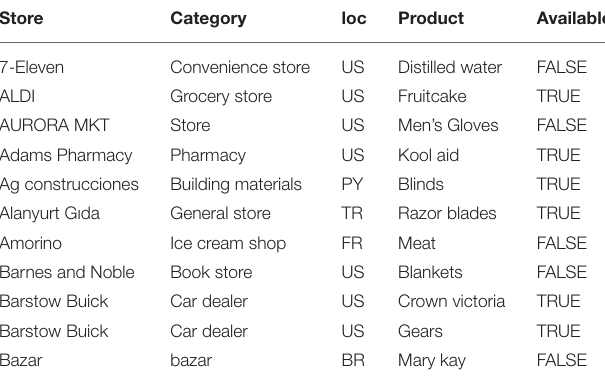
TABLE 3 | Example gold standard R I pairs.